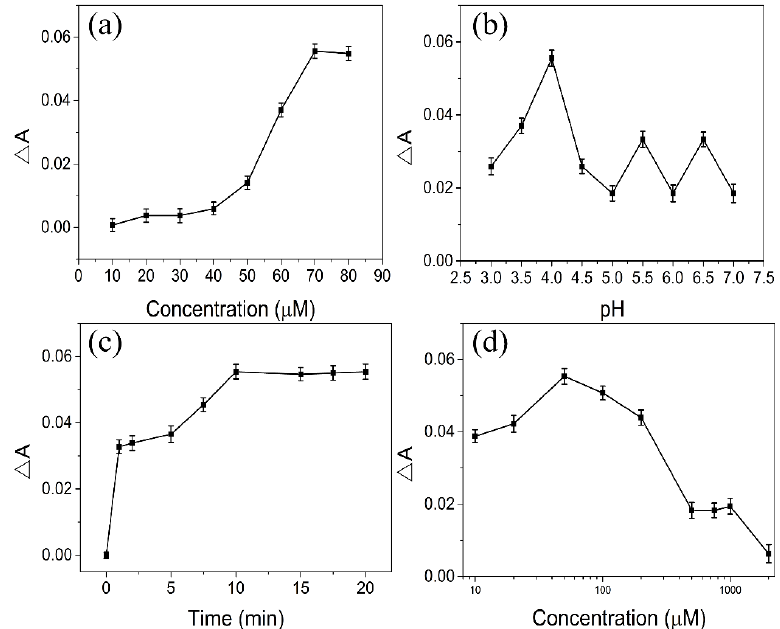
Figure 6. Optimization of developed AuNR probe for the colorimetric detection of As(III): ( a ) Effect of the concentration of DTT; ( b ) Effect of the pH value of NaAc-HAc buffer (10 mM); ( c ) Effect of the reaction time; ( d ) Effect of the concentration of NaCl.